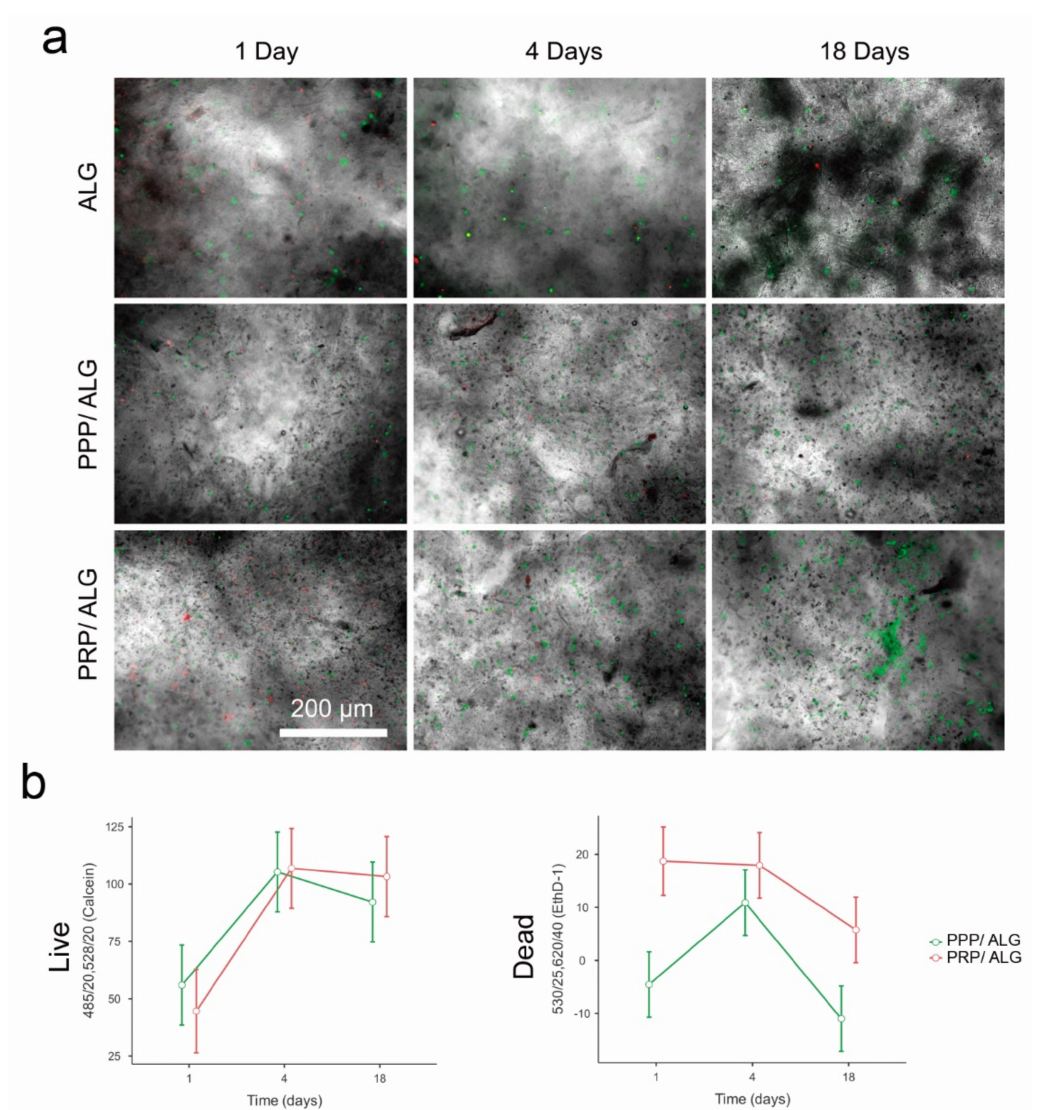
Figure 4. Live/dead assay results for ALG, PPP/ALG, and PRP/ALG dressings on days 1, 4, and 18 after bioprinting. ( a ) Fluorescence microscopy images of live (calcein = green) and dead (etdh-1 = red) cells. Original magnification, 4 × . Scale bar, 200 µ m. ( b ) Fluorescence readouts (fluorescence arbitrary units) obtained for PPP/ALG (green) and PRP/ALG (red) cellular dressings minus the signal obtained for acellular scaffolds. The graph in the left represents the fluorescent signal of calcein living cells, and the graph in the right represents the fluorescence emitted by etdh-1 in dead cells. ALG, alginate; PPP, platelet-poor plasma; PRP, platelet-rich